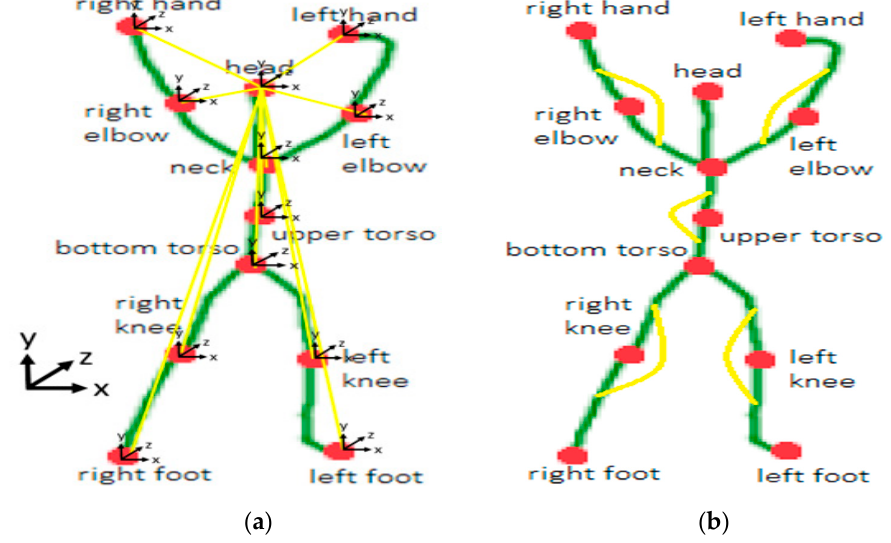
Figure 7. Kinematic posture. ( a ) Linear joint position feature (LJPF), ( b ) angular joint position feature (AJPF).